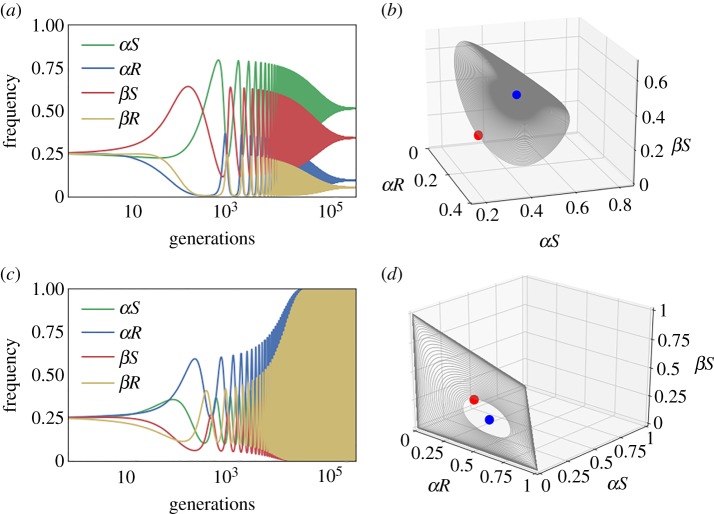
Oscillations of cooperation can either converge or diverge. We plot the frequencies of the four host types in the population with time (a, c) and in a three-dimensional plane (b,d) for c = 0.05, δ = 0.03, Tβ = 0.25, Tα = 0.9Tβ (based on iterations of equations (S1–S4) of electronic supplementary material, S1). (a,b) b/c = 6. The population spirals and converges to the polymorphic equilibrium. (c,d) b/c = 10. The population oscillates and diverges. The red dots in panels (b,d) represent the initial state of the population, with equal proportions of the four host types, and the blue dots represent the system's polymorphic equilibrium.